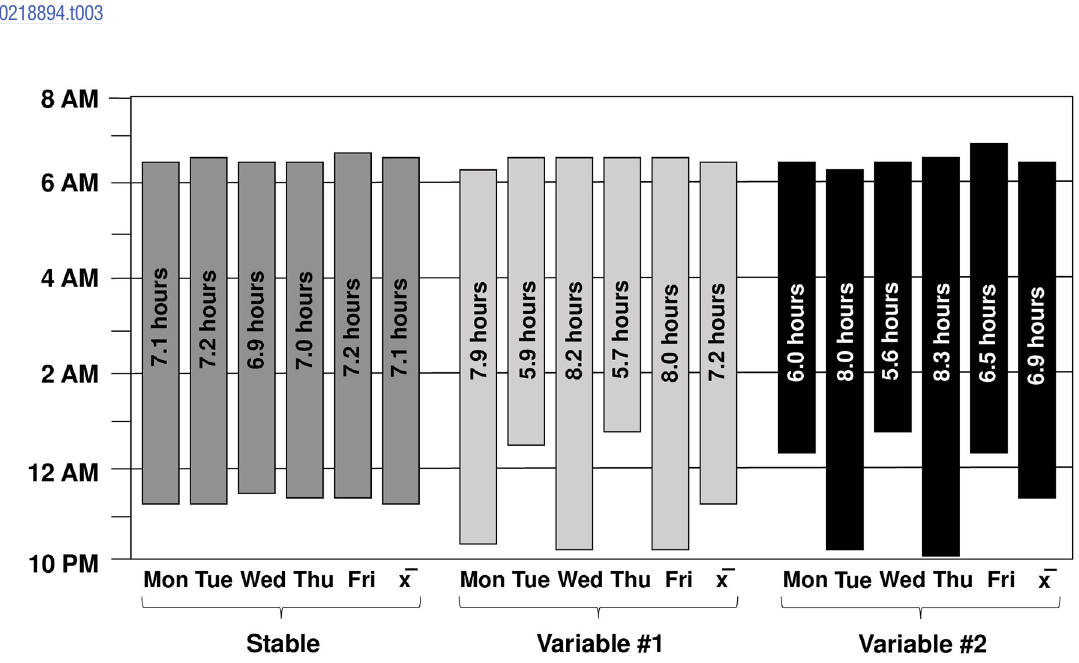
a Due to missing data during the run-in period, n = 15 on Monday and Tuesday and n = 16 on Wednesday through Friday of the run-in. b Efficiency represents the percent of the period between sleep onset and offset spent in sleep.